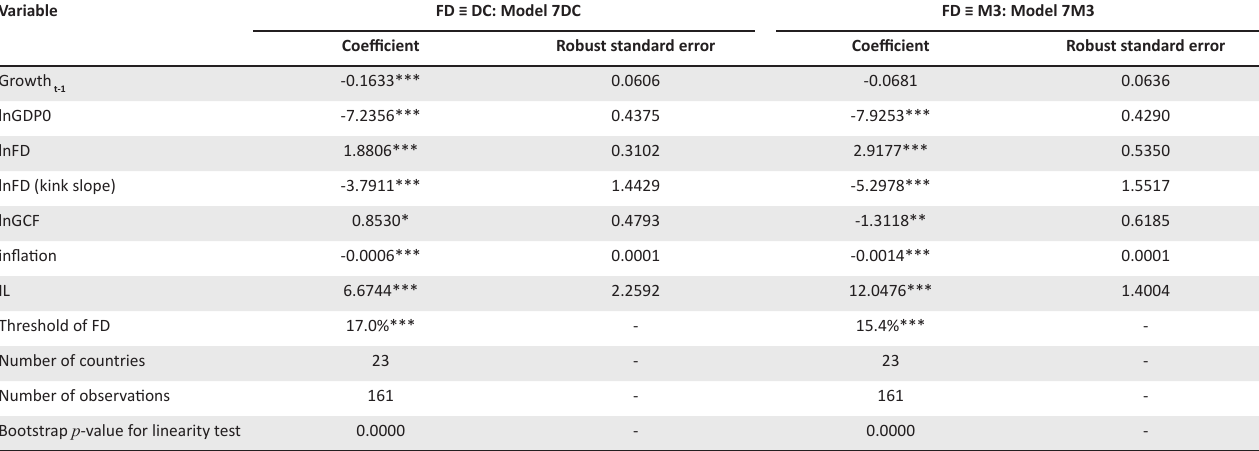
TABLE 2-A1: Dynamic panel threshold model estimations.